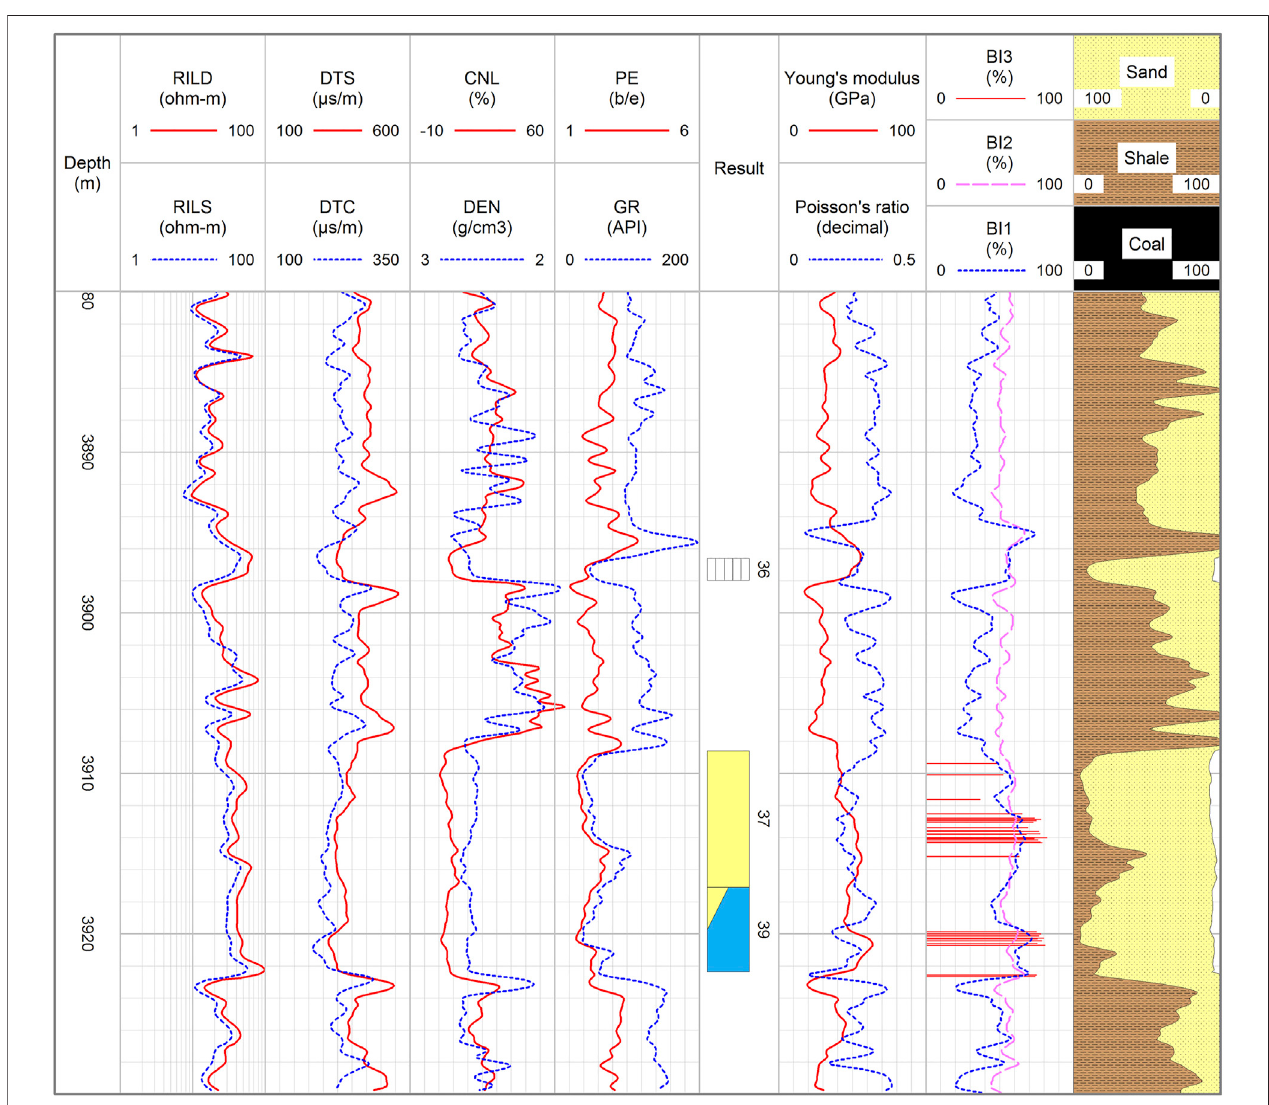
FIGURE 2 | Well #1 logging interpretation results of He8